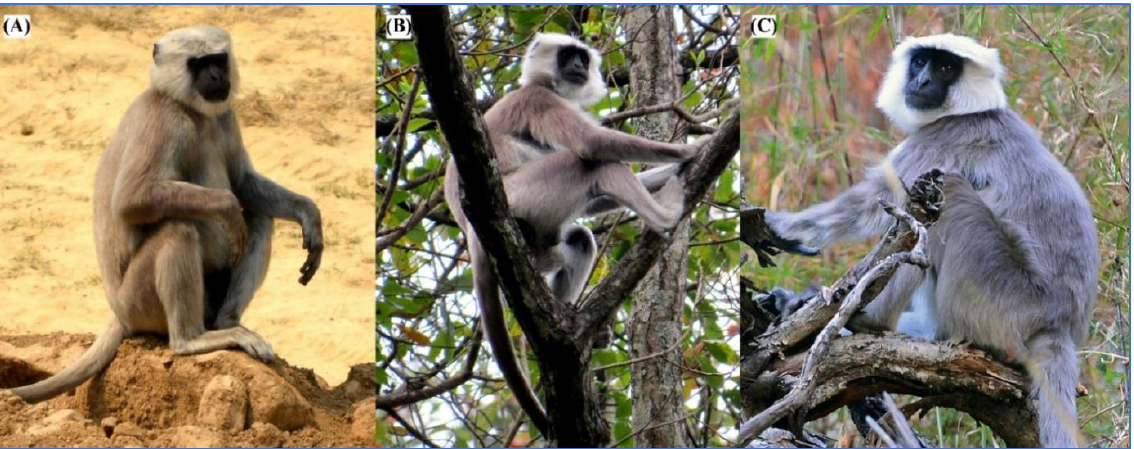
Figure 1. Himalayan langurs from different elevations in Nepal. ( A ) Adult female from the lowland Terai (283 m asl) (photo by Laxman Khanal). ( B ) Adult male from the mid-hill zone (865 m asl) (photo by Mukesh K. Chalise). ( C ) Adult male from the mountain region (3200 m asl) (photo by Randall C. Kyes).